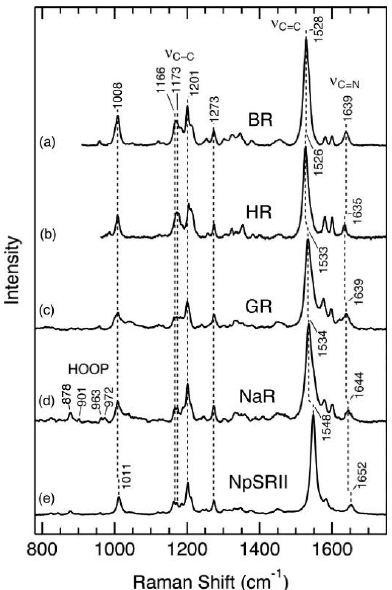
Figure 12. RR spectra of selected microbial rhodopsins. ( a ) BR (light-adapted state) in the purple membrane of Halobacterium salinarum , 532 nm excitation. ( b ) HR from Natronomonas pharaonis , 532 nm excitation. ( c ) GR, 441.6 nm excitation. ( d ) NaR from I. alkaliphilus , 441.6 nm excitation. ( e ) SRII from